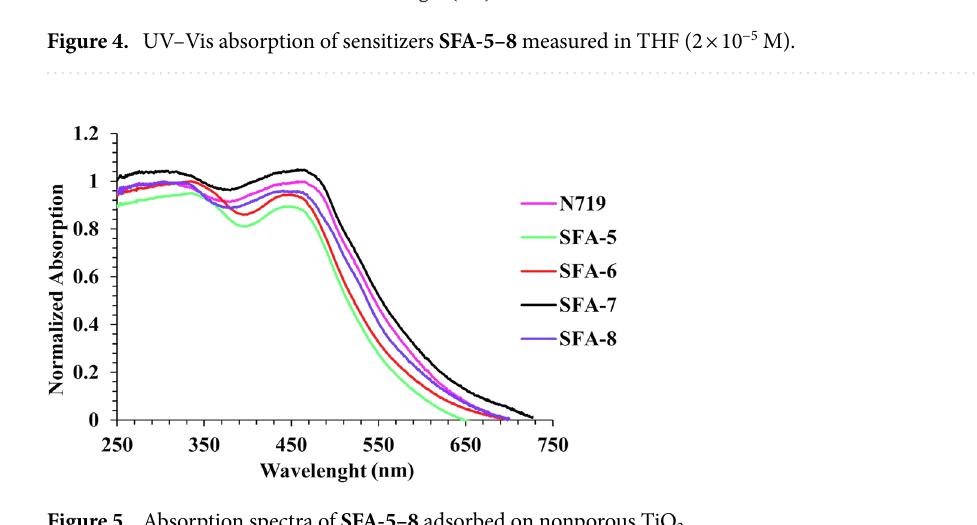
Figure 5. Absorption spectra of SFA-5–8 adsorbed on nonporous TiO 2